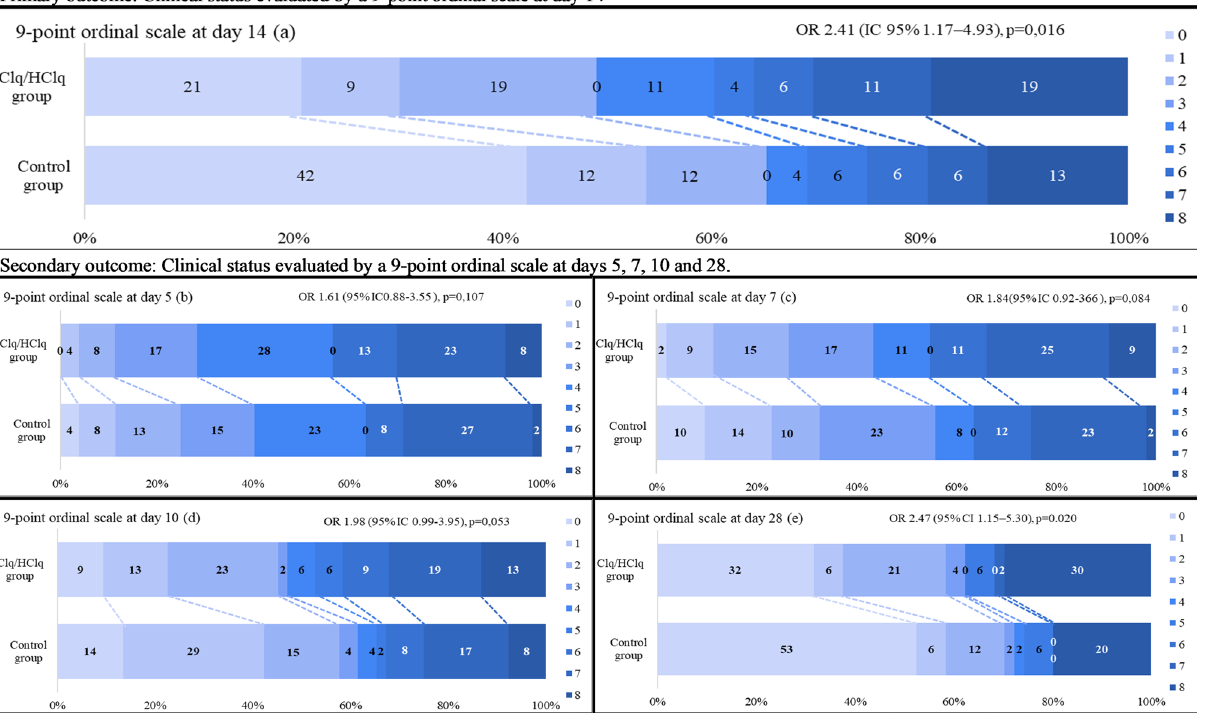
(Table 2). SOFA scores, CRP levels, neutrophil/lymphocyte ratios on days 5, 7, 10, 14 and 28 (Supplementary Table S3) and the development of coagulopathy until the 28th day (Table 2) were not different between groups. The safety population consisted of 138 patients, of whom 68 were in the Clq/HClq group and 70 were in the control group. There was no difference between groups regarding the proportion of patients with arrhythmia (4 [5.9%] in the Clq/HClq group vs 1 [1.4%] in the control group (RR 3.92 [95% CI 0.45 to 33.95]), p = 0.176; Table 2). Among patients who had arrhythmia, only one patient in the Clq/HClq group stopped treatment on the